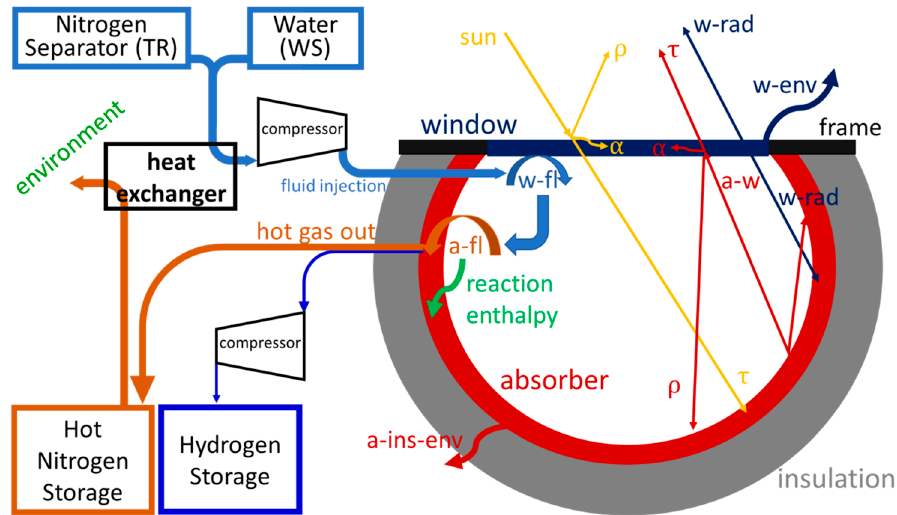
Figure 3. Thermodynamic solar reactor model, based on [20] with own adaptations.